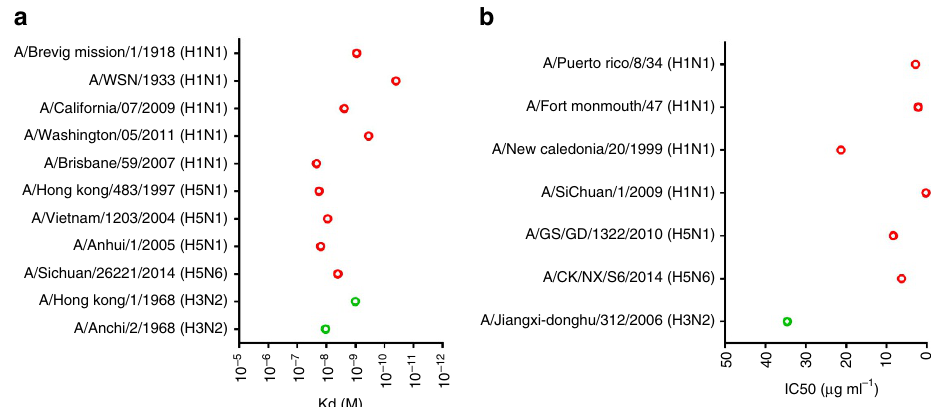
Figure 1 | In vitro binding and neutralization activity of 3E1 mAb. ( a ) Binding affinity (Kd) of 3E1 mAb to the HAs of various strains of H1, H5 and H3 subtype IAVs. Data represent a representative experiment from three independent experiments. ( b ) In vitro microneutralization (IC 50 ) of 3E1 mAb against various strains of H1, H5 and H3 subtype IAVs. Graphs used for IC 50 values determined by averaging neutralization titre of three independent